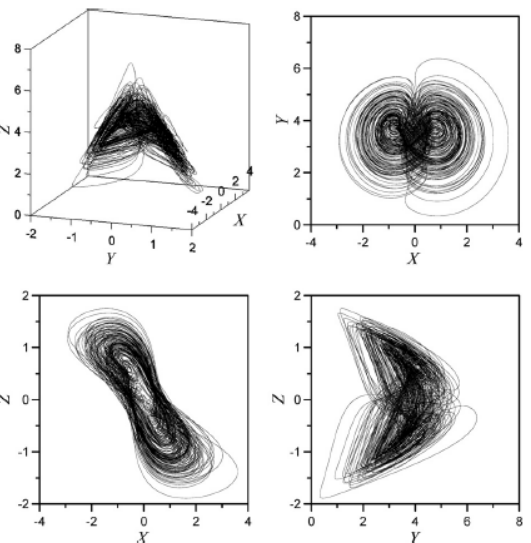
Figure 2. Trajectories for the system (7) where k i = 0.1 ( i = 1,2,3 ) and τ =